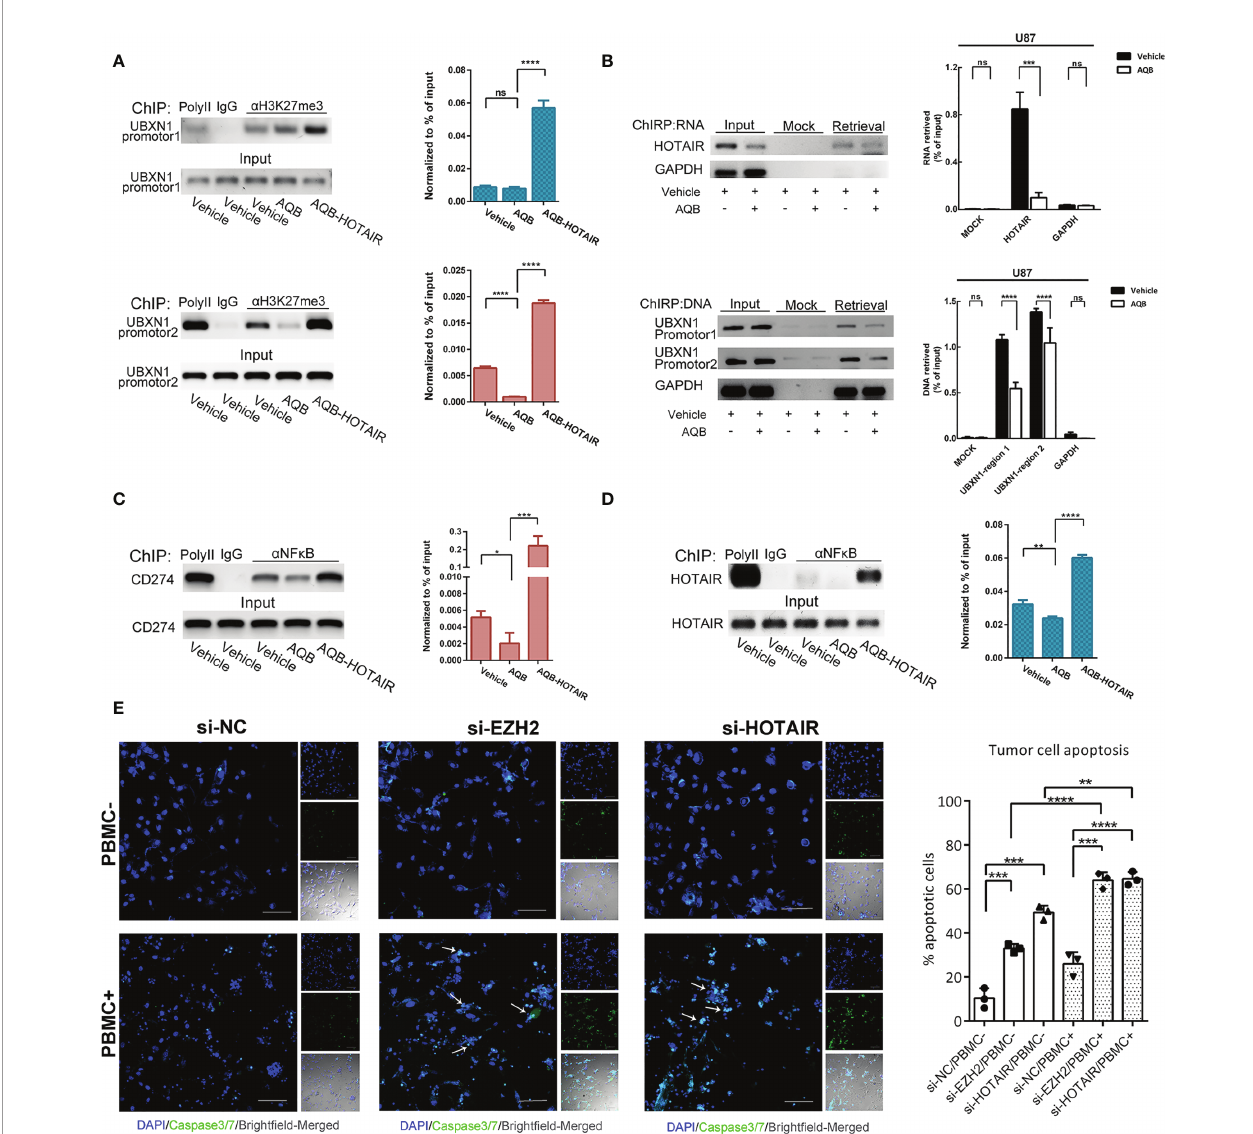
FIGURE 5 | HOTAIR inhibited the expression of UBXN1 by epigenetic modi fi cation. (A) ChIP assay detected the H3K27me3 modi fi cation on the promotor region of UBXN1. (B) Upper: ChIRP assay enriches HOTAIR RNA with high yield and speci fi city. Lower: ChIRP assay detect the HOTAIR binding region on the promotor of UBXN1 . (C) ChIP assay detected NF- k B binding on the promotor of CD274 in U87 treated with AQB or vehicle as control. (D) ChIP assay detected NF- k B binding on the promotor of HOTAIR in U87 cells treated with AQB or vehicle as control. (E) T cell killing assay of TBD cells treated with siRNAs for EZH2 and HOTAIR. Cell nuclei were stained by DAPI in blue, and apoptotic cells were displayed by fl uorescent products of caspase 3/7 cleavage (green). For all the statistical histograms above, values are means±s.d. from n=3 independent experiments. The P value was determined by two-sided Student ’ s